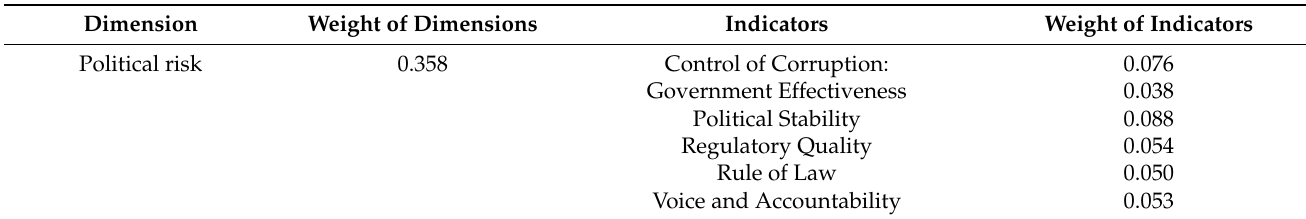
Table 3. Evaluation criteria system for mining investment risk under 3-D. Dimension Weight of Dimensions Indicators Weight of Indicators Political risk 0.358 Control of